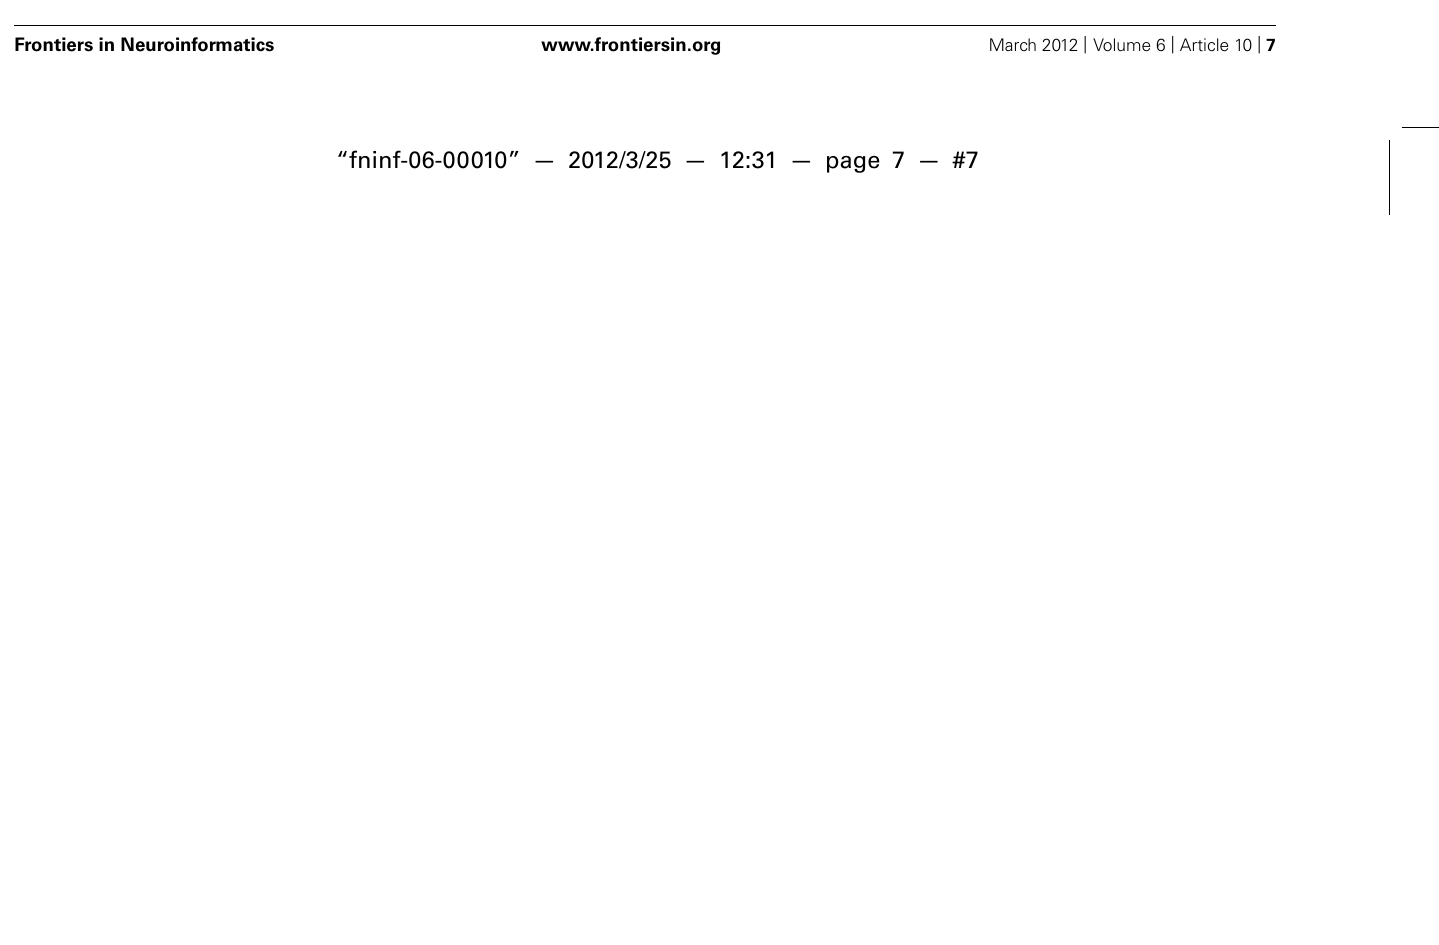
FIGURE 4 |The structural (sMRI) components (red) and corresponding rs-fMRI components (blue). The spatial correlation between component pairs is indicated adjacent to the functional component number. Both sMRI and fMRI aggregate components were converted to z -scores and thresholded at Z > 2. Structural components are displayed at the slices with